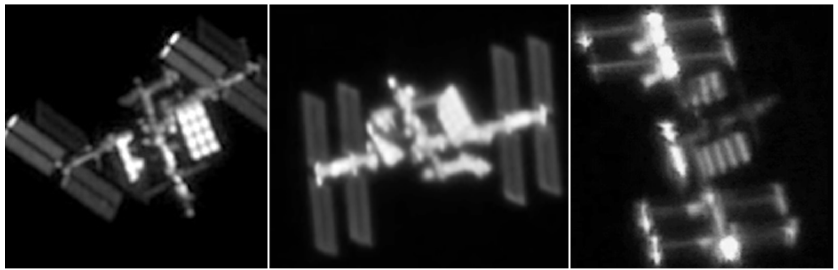
Figure 9. Some real-world turbulence-degraded data for